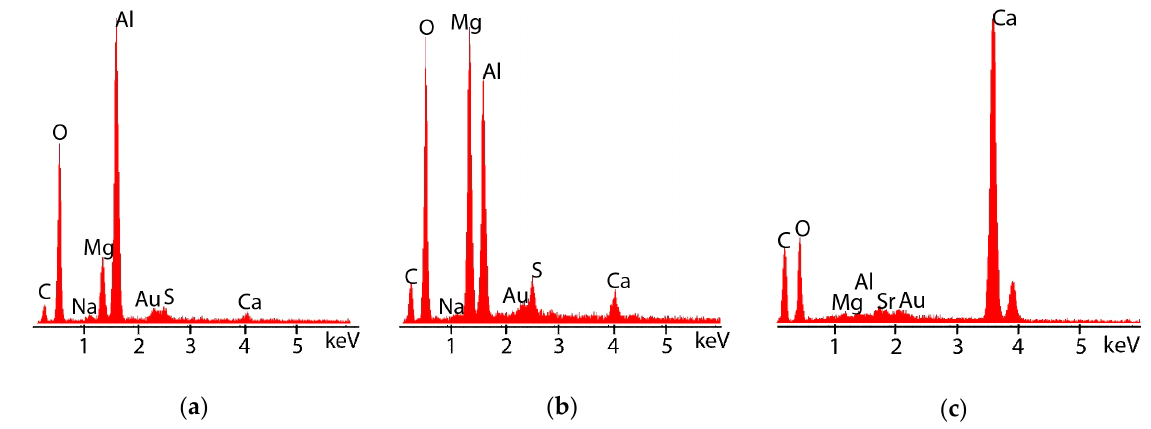
Figure 10. EDX spectra showing elemental composition of regions ( a ) 1, ( b ) 2 and ( c ) 3 of Figure 9. The TSA-coated specimens polarized to − 1100 mV (Ag/AgCl/saturated KCl) showed some